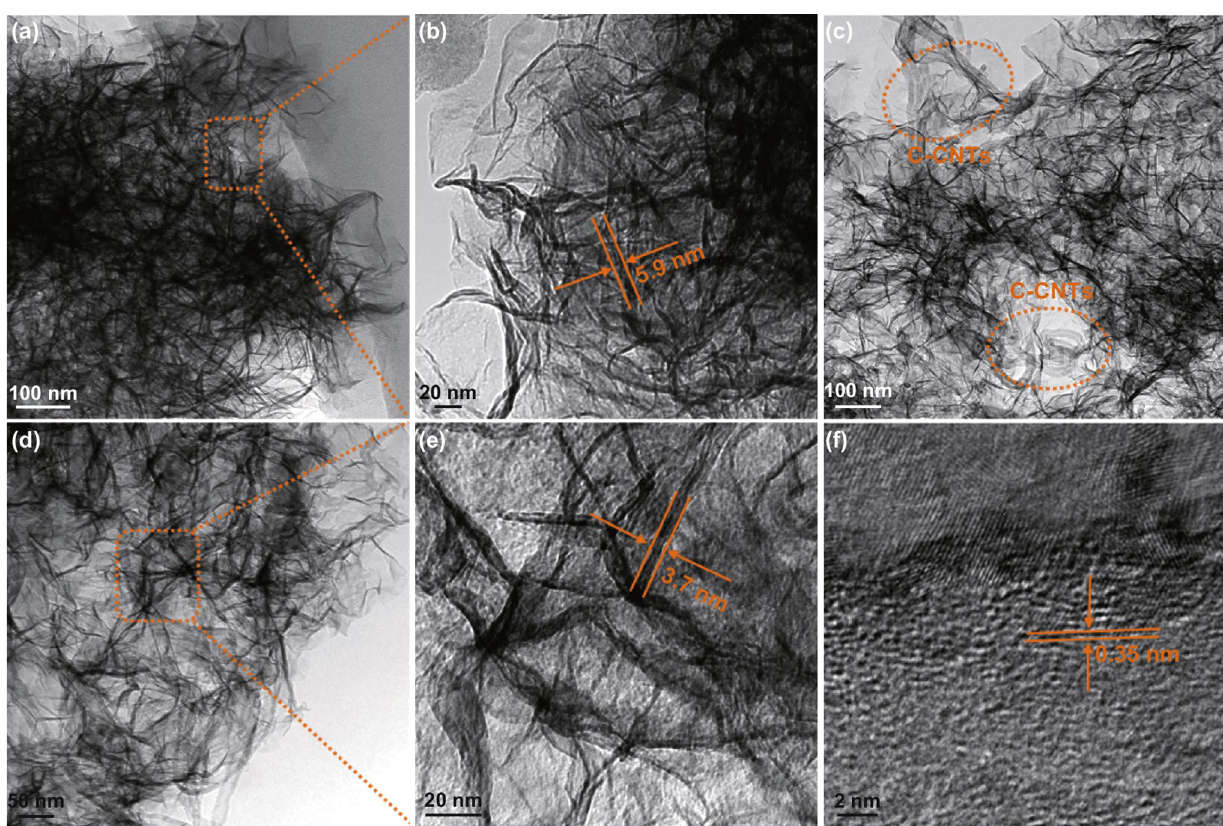
Fig. 2 TEM images of a , b Ni-MOF and c–e Ni-MOF/C-CNTs40 nanosheets with different magnification. f HRTEM image of Ni-MOF/C-